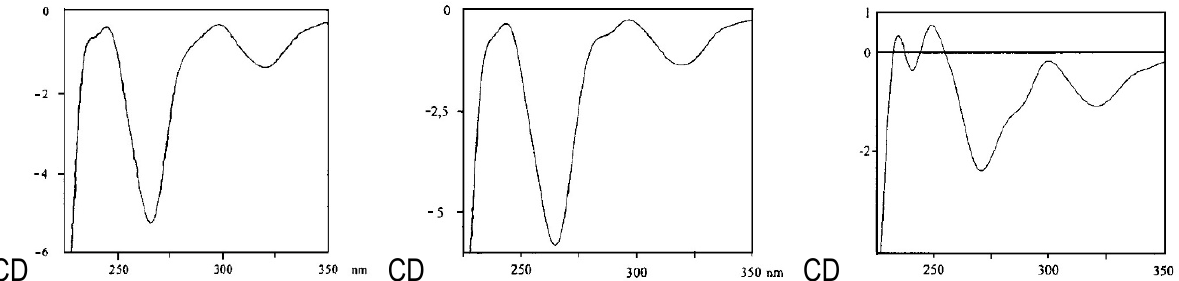
Molecules 2021 , 26 , x FOR PEER REVIEW Figure 4. Comparison of the CD spectra of feralolide ( 1 ) (left), 6- O - β - D -glucopyranosyl-feralolide ( 3 ) (center) and 3 ′ - O - β - D -glucopyranosyl-feralolide ( 2 ) (right) for configurational 3 R determination.